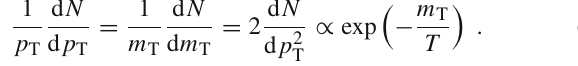
cess down to 80% and 60% of the level optimised by the